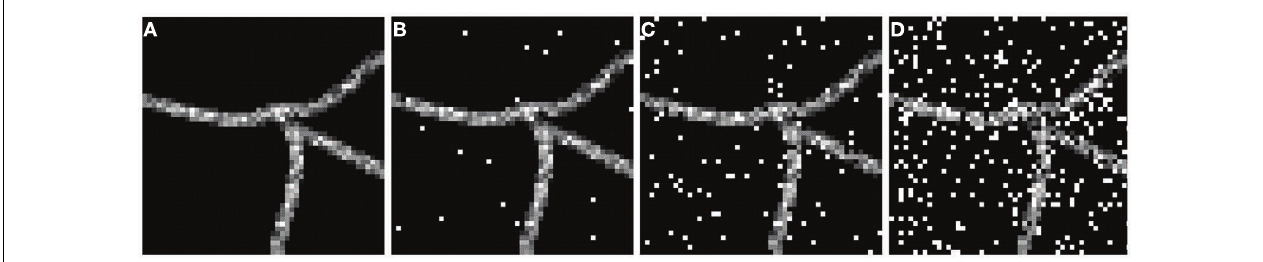
FIGURE 1 | Exemplar frame showing fragment of neural structure corrupted with different levels of noise d : (A) d = 0, (B) d = 0.01, (C) d = 0.07, (D) d = 0.22.